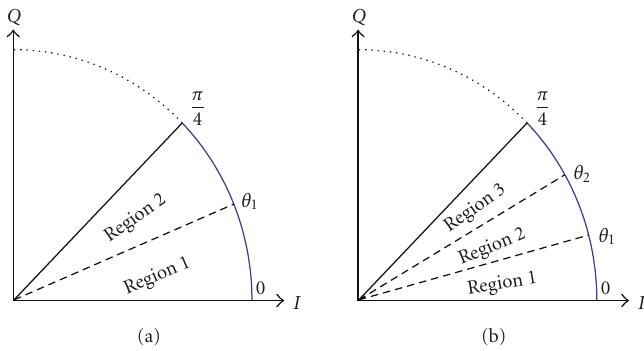
Figure 1: Linear amplitude approximations. (a) Two angular intervals. (b) Three angular intervals.